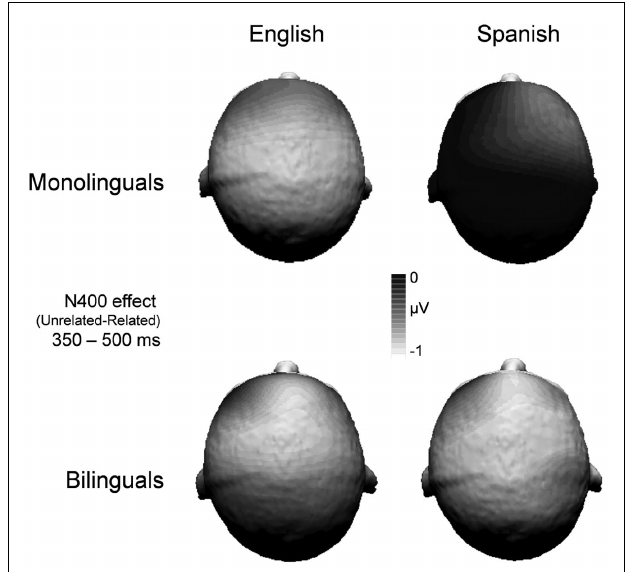
FIGURE 1 |Topographic maps for the N400 time window (350–500ms) by language group, resulting from the subtraction of English related from English unrelated and Spanish related from Spanish unrelated.